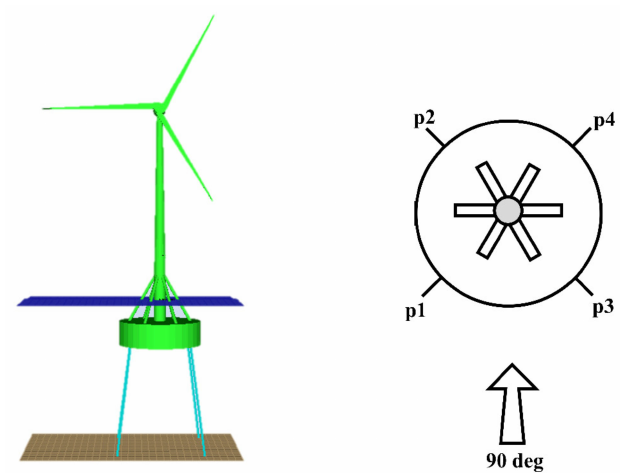
Figure 2. Physical model of FOWT with inclined tension legs.